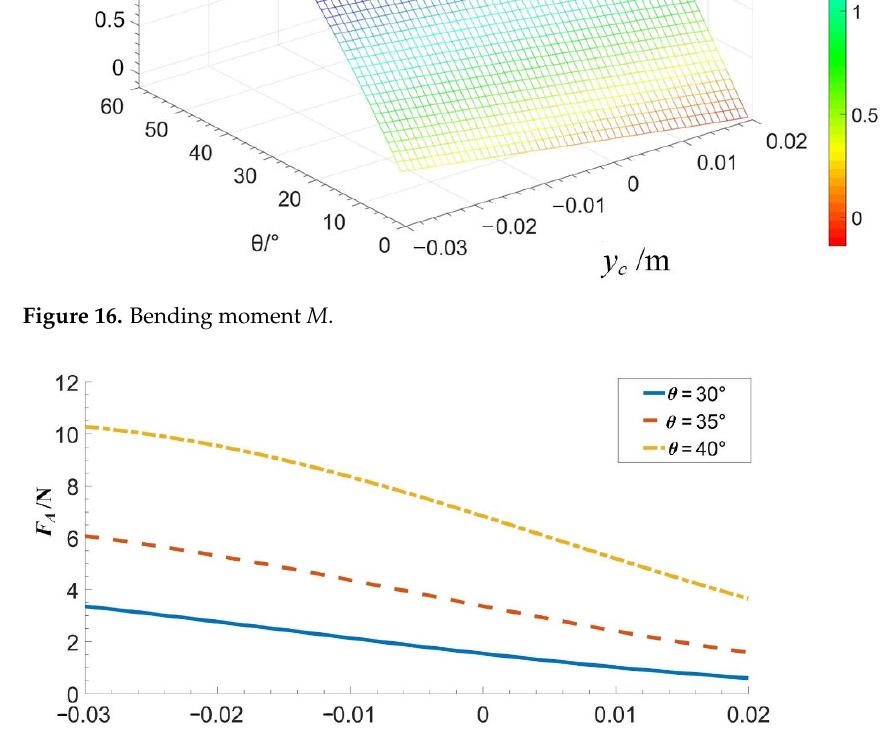
where L f is the distance between the two flexible fingers; n is a safety coefficient, 0 < n < 1 . The gaps between the two adjacent flexible fingers on the left and right rollers were set as 30 mm and 10 mm,